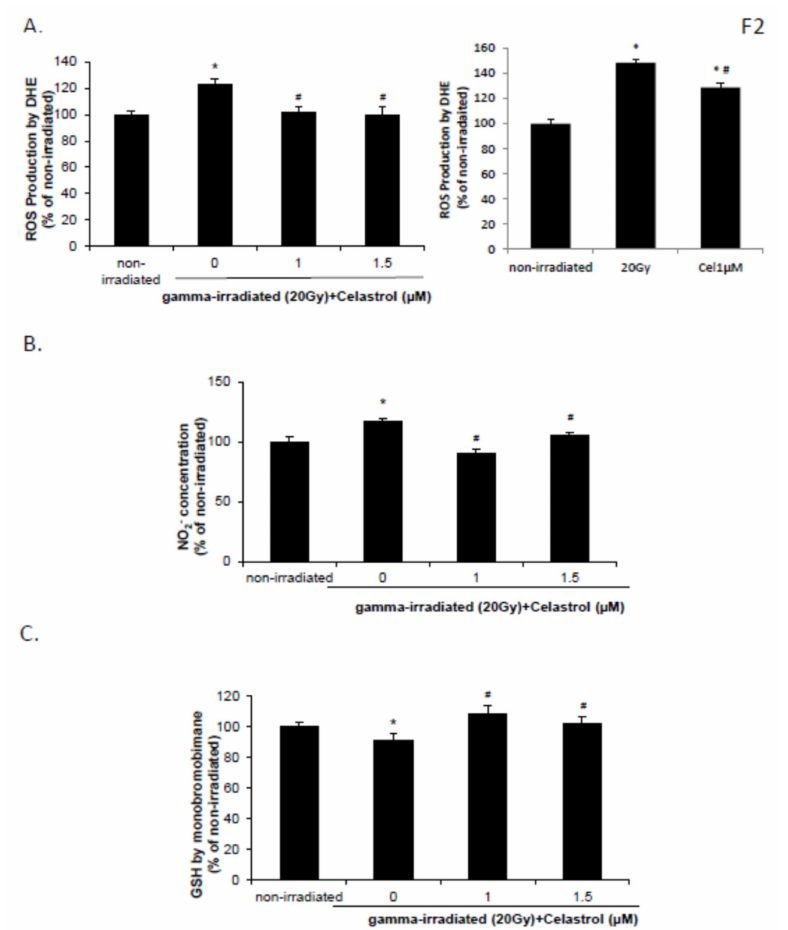
Figure 2. E ff ects of celastrol on free radical and glutathione (GSH) production in HaCaT and human skin fibroblast cells after gamma irradiation. HaCaT and human skin fibroblast cells were subjected to gamma irradiation with 20 Gy followed by 24 h treatment with celastrol at designated concentrations. DMEM or EMEM group without any drug treatment and gamma radiation exposure served as the control. ( A ) Reactive oxygen species (ROS) production in HaCaT (left panel) and skin fibroblast cells (right panel) was assayed by DHE. ( B ) NO 2 − concentration was evaluated in HaCaT cells by Griess reagent. ( C ) GSH production was evaluated in HaCaT cells. All data are expressed as mean ± S.E.M ( n = 5). Comparisons between groups were analyzed by One-Way ANOVA followed by Tukey’s post-hoc test. * p < 0.05 vs. non-irradiated. # p < 0.05 vs. irradiated and no drug